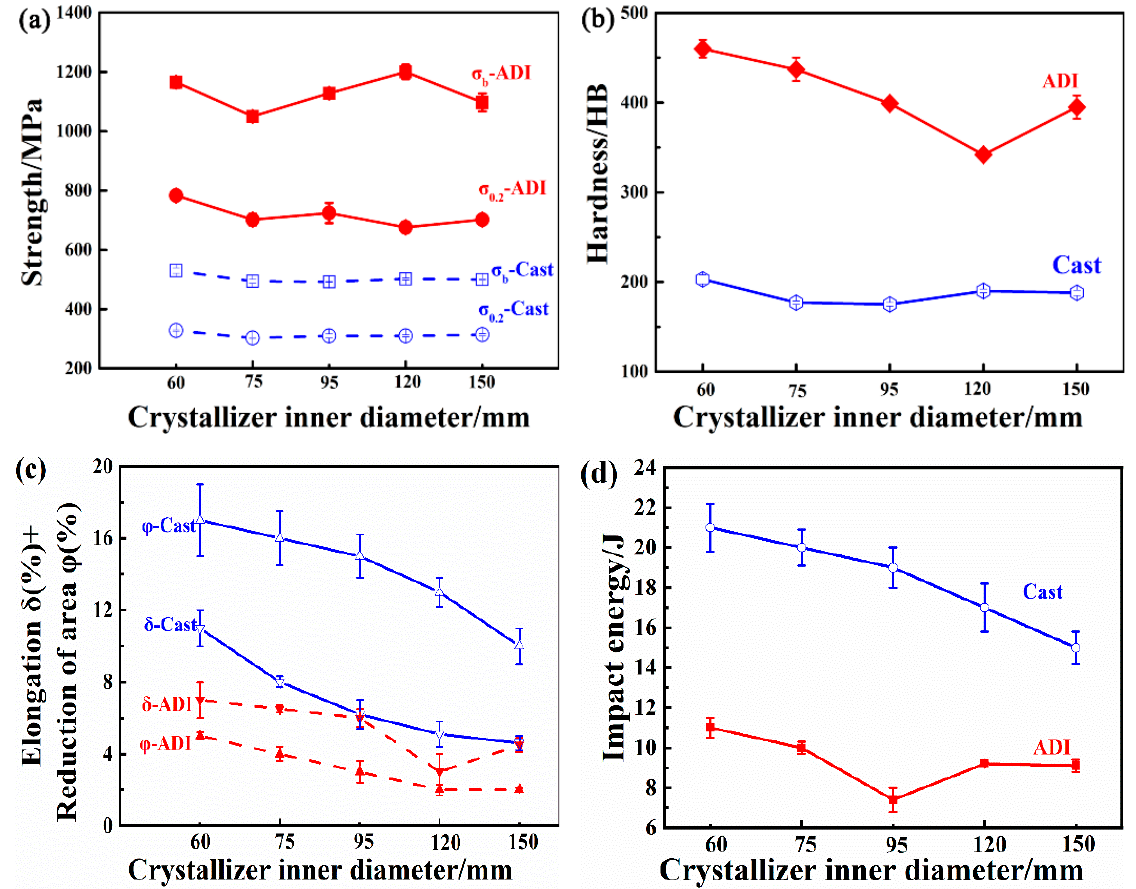
Figure 6. Mechanical properties of different as-cast ductile iron and ADI state specimen: ( a ) strength; ( b ) hardness; ( c ) elongation and the reduction of area; ( d ) impact energy.